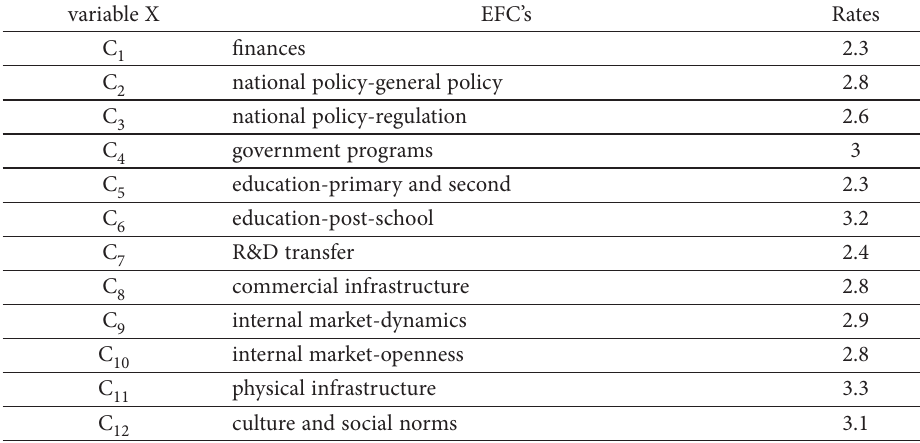
Table 4. Real level: Colombia’s EFC’s rates